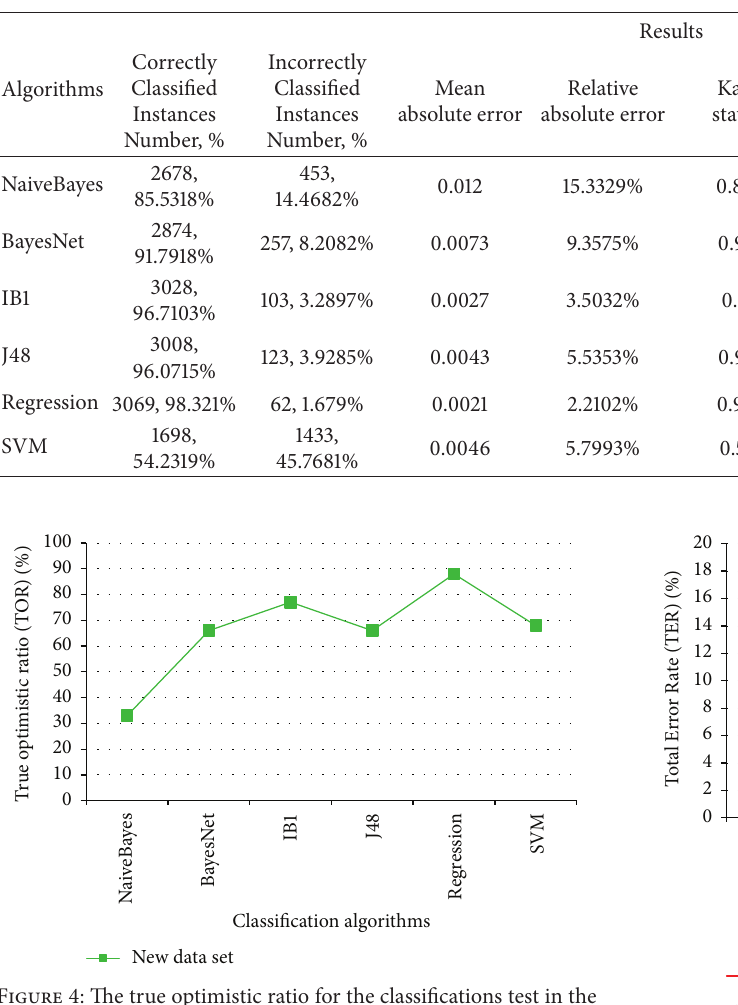
Table 2: The statistical analysis of data set 2 for specified classification methods.